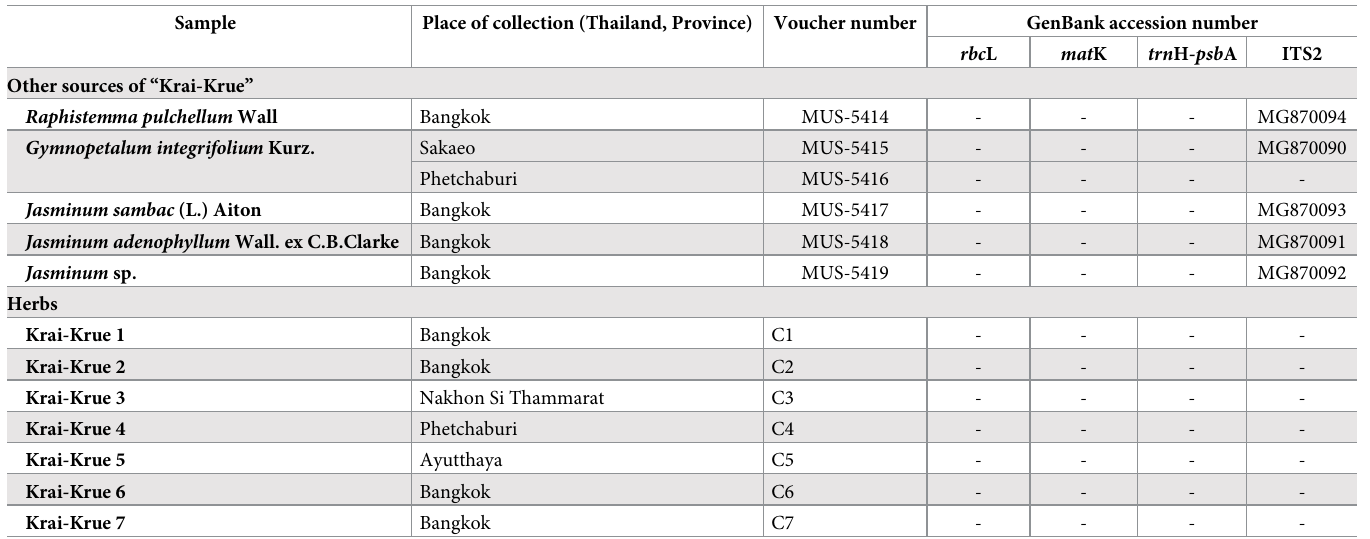
Total genomic DNA was extracted from 80 to 100 mg of fresh leaves of the plants or from 15 to 25 mg of dried commercially available crude drug samples. DNA was extracted by a DNeasy Plant Mini Kit (Qiagen, Germany) according to the manufacturer’s protocol. DNA quality and quantity were determined by agarose gel electrophoresis; the gels were stained with ethidium bromide and visualized under UV light.